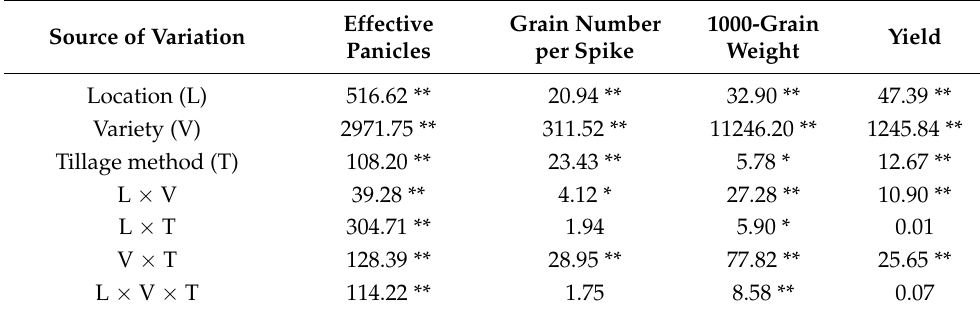
Table 7. Analysis of variance of corn yield and its constituent factors following each treatment (F-value).